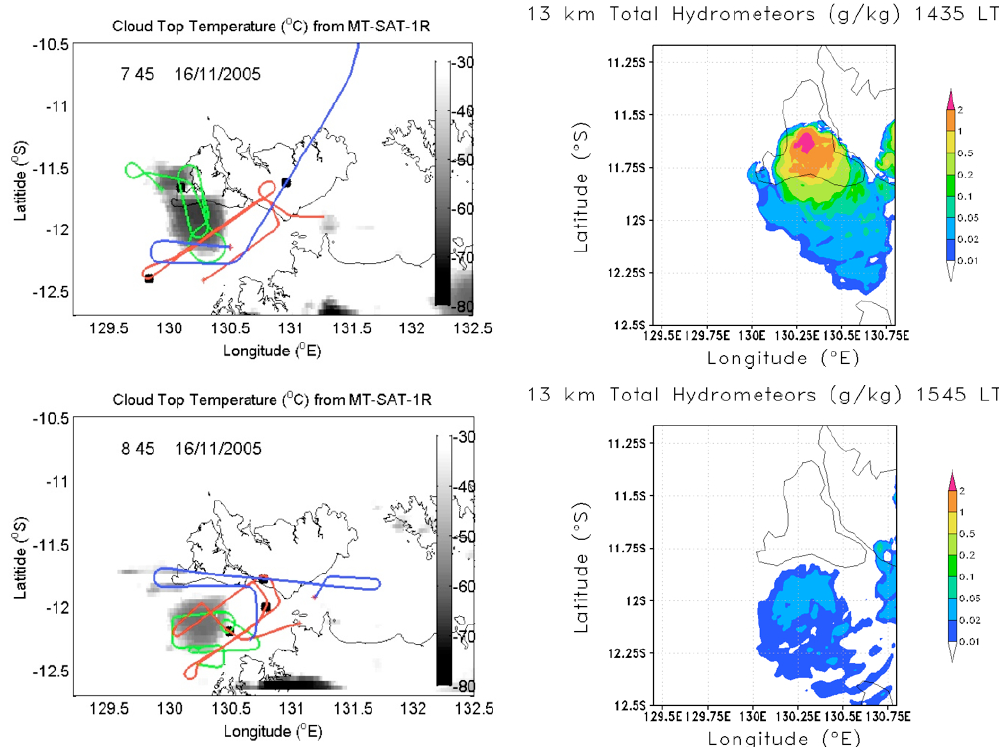
Fig. 9. Comparison of IR satellite anvil observations and aircraft flight tracks (left) with modeled total hydrometeors at 13km (right). A summation of the area containing simulated total hydrometeors ≥ 0.01gkg − 1 provides an estimate of the anvil extent. Egrett flight track is in red, Geophysica in green, and Falcon in